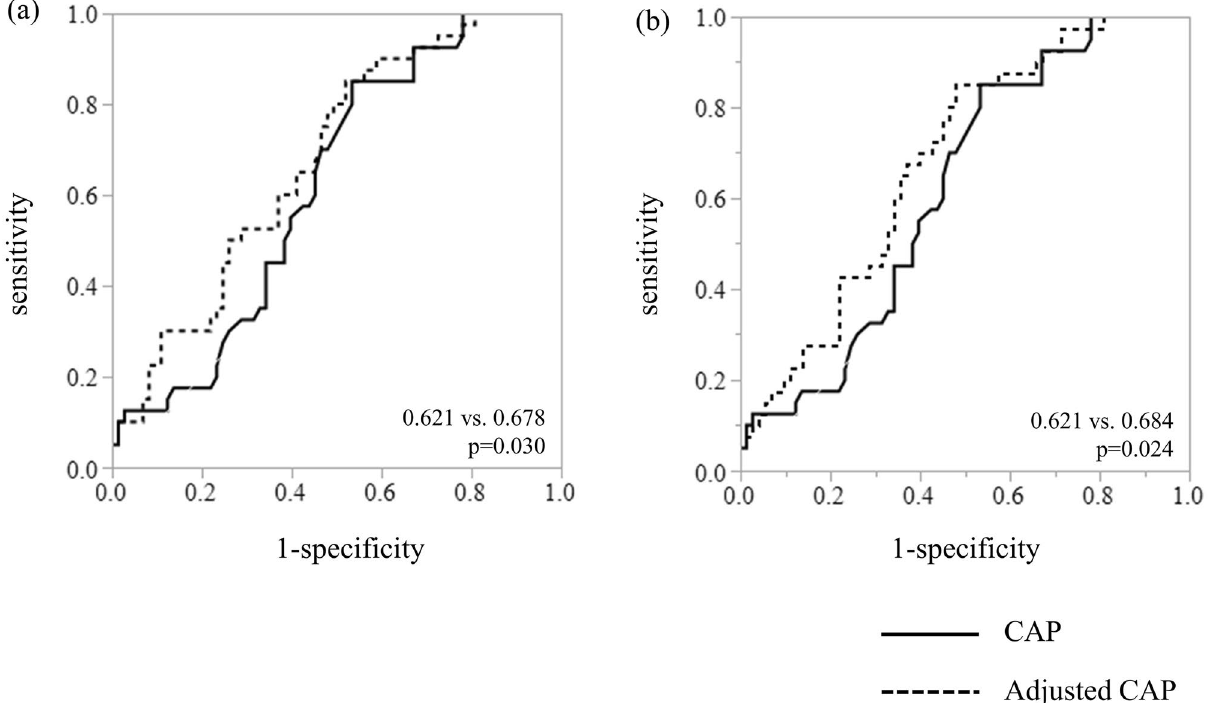
Figure 2. Comparison of the AUROC for the CAP (solid line) and ( a ) Model 1-adjusted CAP or ( b ) Model 3-adjusted CAP (dotted line) for detecting patients with a steatosis score ≥ 2. The p value was obtained by the DeLong